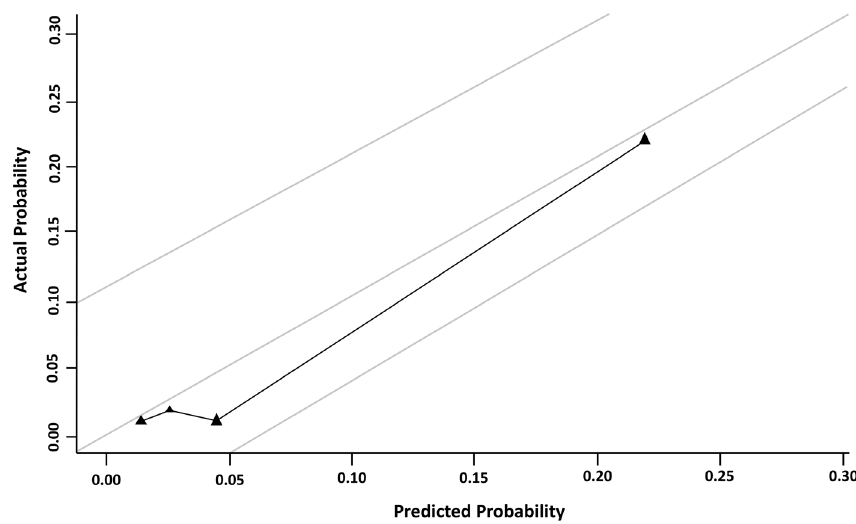
Figure 4. Calibration plot of the nomogram using validation